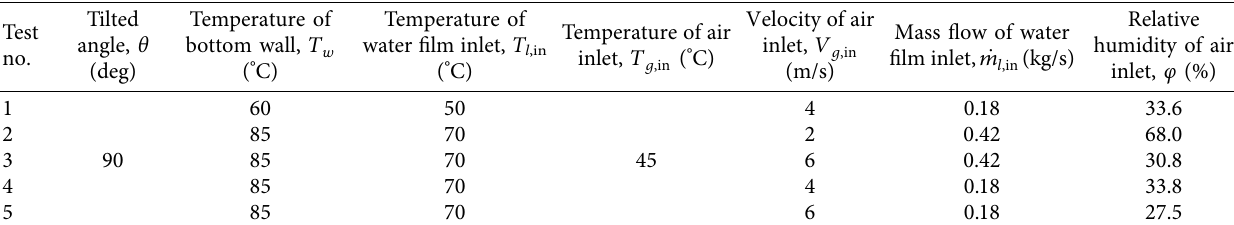
Table 4: Thermodynamic parameters of the analyzed